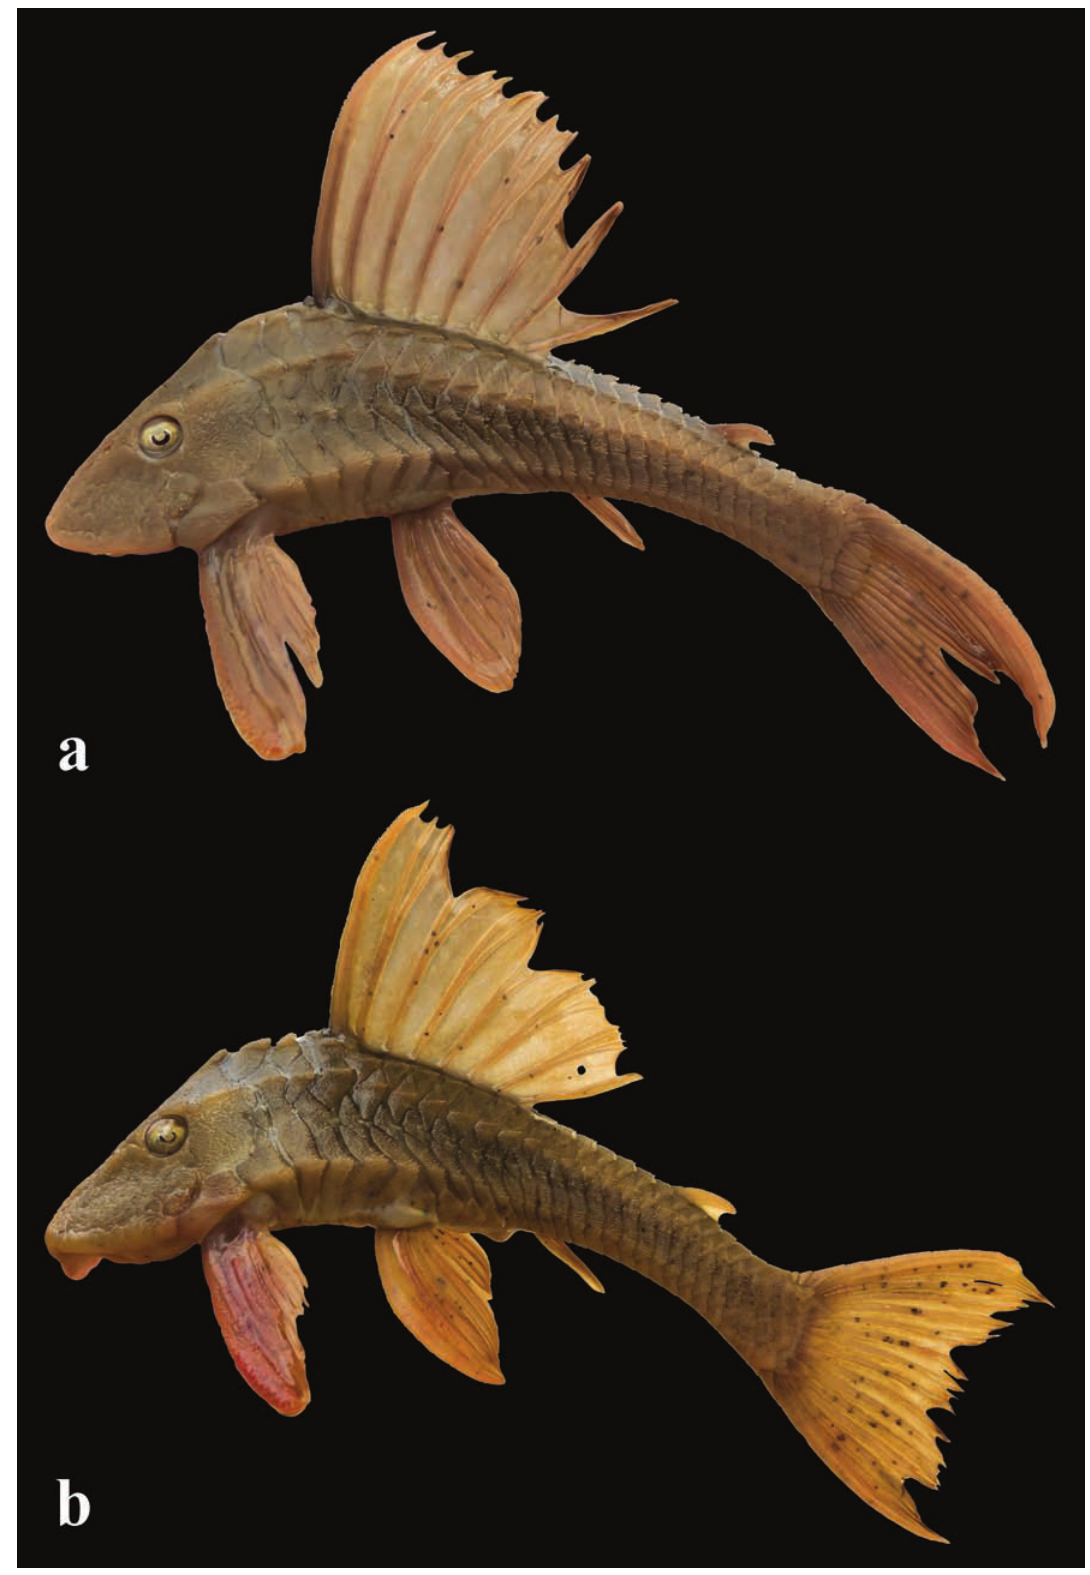
Fig. 11. Color pattern of live specimens of Hypostomus basilisko , paratypes (a) ZUFMS-PIS 3086, 150.5 mm SL, showing reddish-brown pattern; (b) ZUFMS-PIS 3086, 150.0 mm SL, showing yellowish-brown